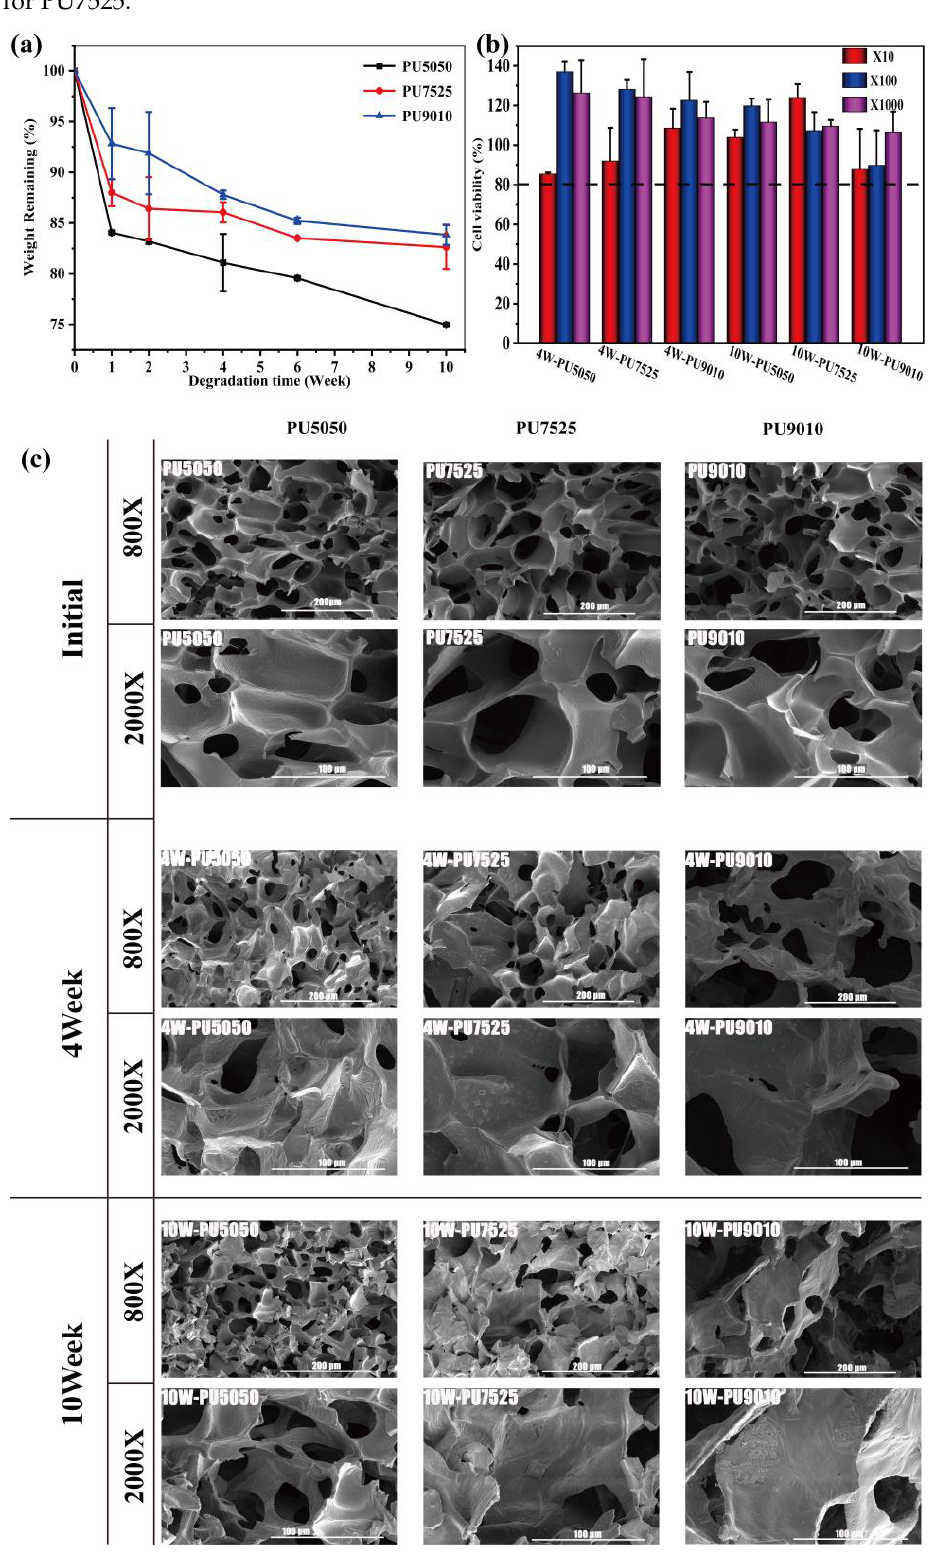
Figure 2. ( a ) Mass retention rate of the WPU scaffolds over 10 weeks. ( b ) The cytotoxicity of degradation solutions of WPU scaffolds with different hydrolysis times. ( c ) The WPU scaffolds’ morphologies after hydrolyzing for 4 and 10 weeks. The data are shown as mean ± SD (n ≥ 3). Table 2. pH values of the WPU scaffolds over 10 weeks.